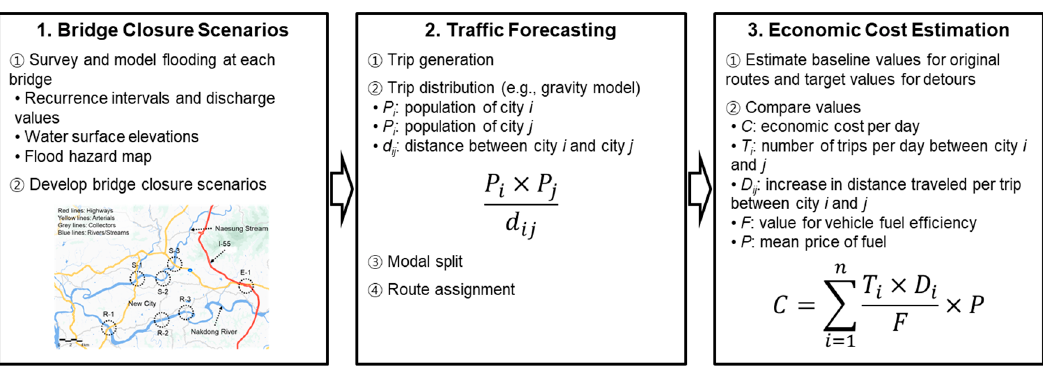
Figure 2. Framework to evaluate economic impact of bridge closures on road users.